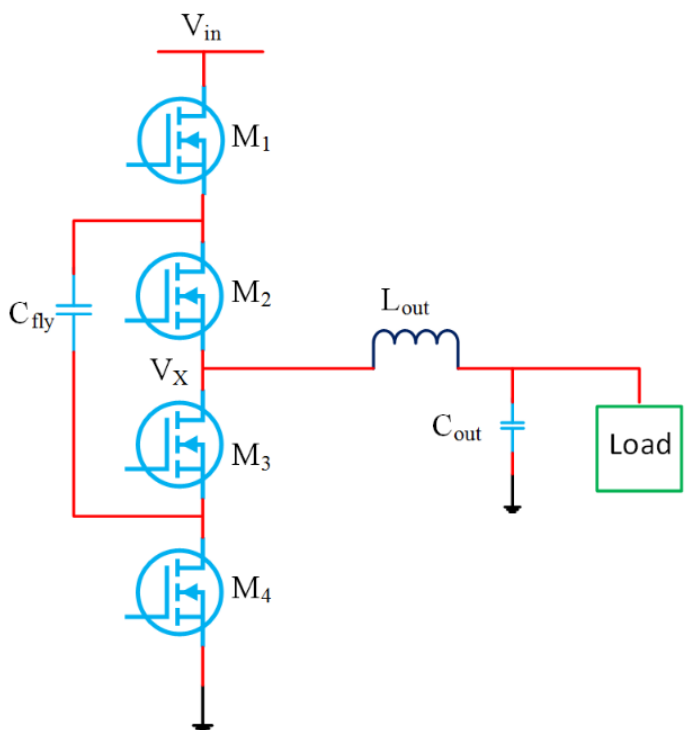
Figure 8. Schematic of the 3-level power converter [72]. Reproduced from [72], IEEE Journal of Solid State Circuits: 2012.